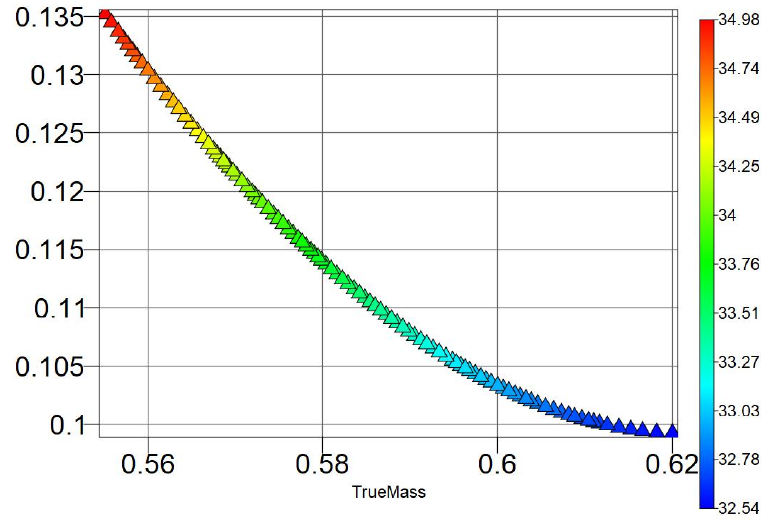
Figure 13. Pareto front.